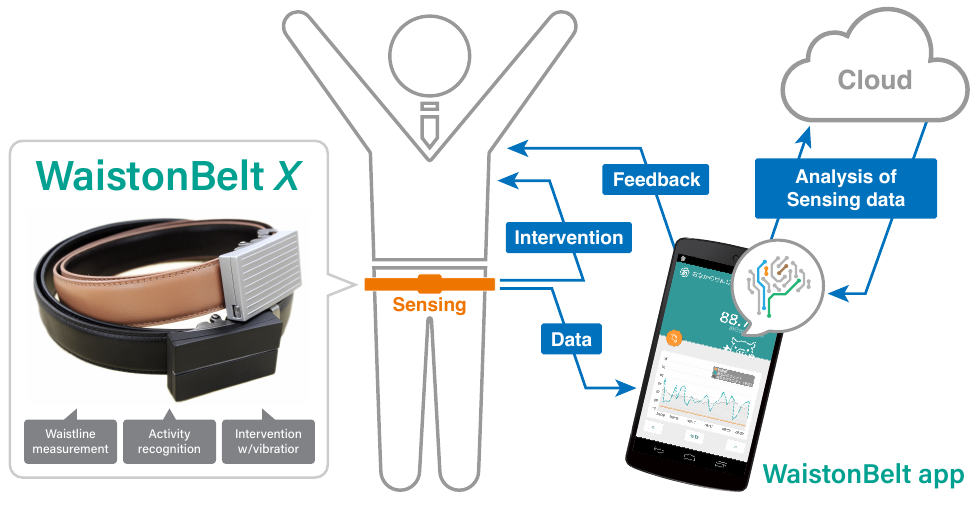
Figure 1. WaistonBelt